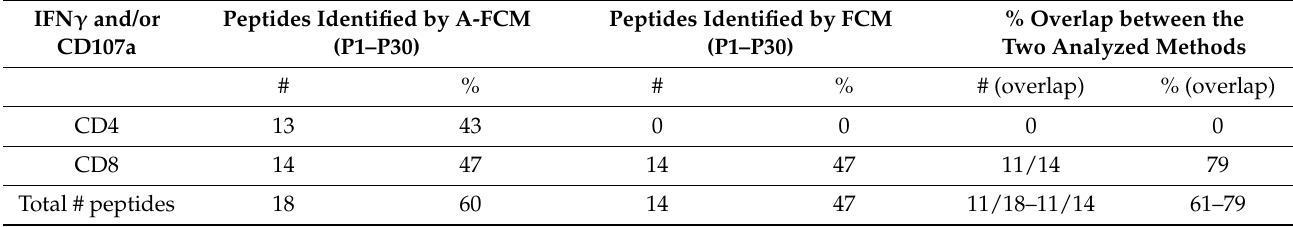
Table 2. Identification of peptides by using dual-function (IFN γ and CD107a) to three vaccine sets. CD4+ and CD8+ T-cell responses to peptides in 3 sets of glioma vaccine (S1–3) and their booster were analyzed by activation marker-inclusive FCM (A-FCM) and standard FCM. Overlapping peptides are those identified by both A-FCM and the FCM